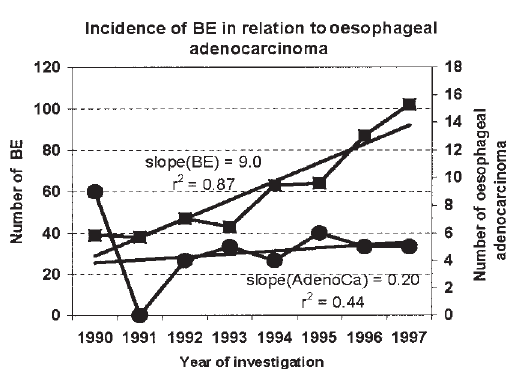
Figure 3 The 3.5-fold rise in the incidence of SIM confirmed at histol- ogy (BE with SIM, HistoSIM; dots) accompanied the 3.3-fold increase in the comprehensive BE group diagnosed at endoscopy and/or histology (EndoBE, BE with SIM, His- toSIM; squares). Linear regressions (slope [BE] = 10.5; slope [SIM] = 7.2) and the gender distribution (bars) of patients with SIM are shown.